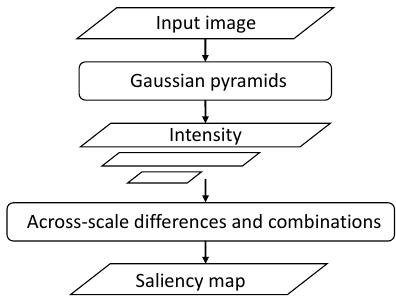
Figure 2. Flowchart of the SIFT detector.